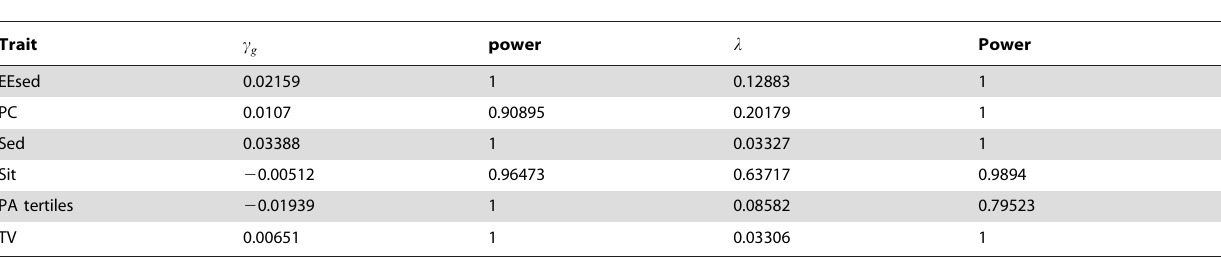
Table 6. Power to detect GxAge interaction effects.